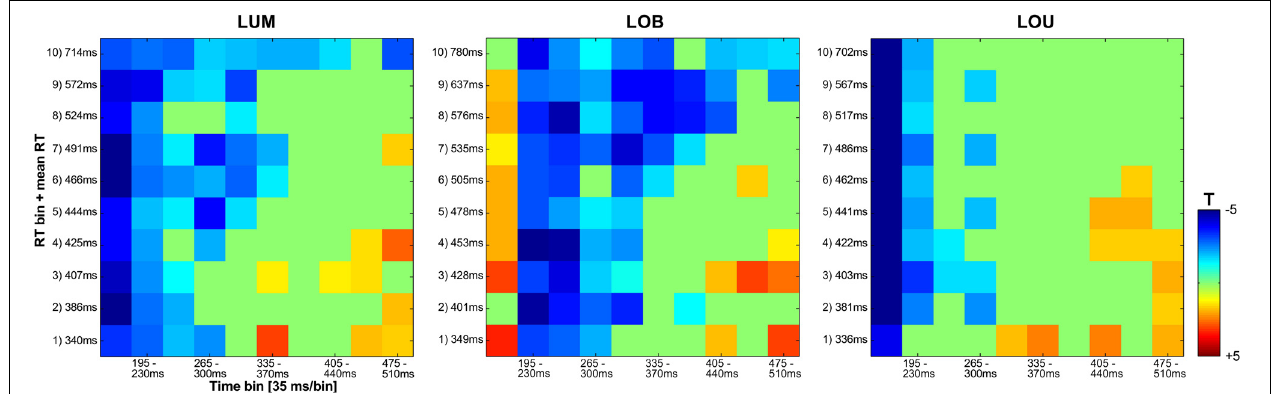
FIGURE 6 | Statistical analyses for the vincentized ERLs (PO7/PO8) based on bootstrap t -tests against zero (FDR corrected p -values). The reliable occurrence of posterior asymmetries was tested in 10 bins within an overall time window from 160 to 510ms subsequent to the feature change(s). While a blue square represents negativity in the ERL that differed significantly from zero, a red square